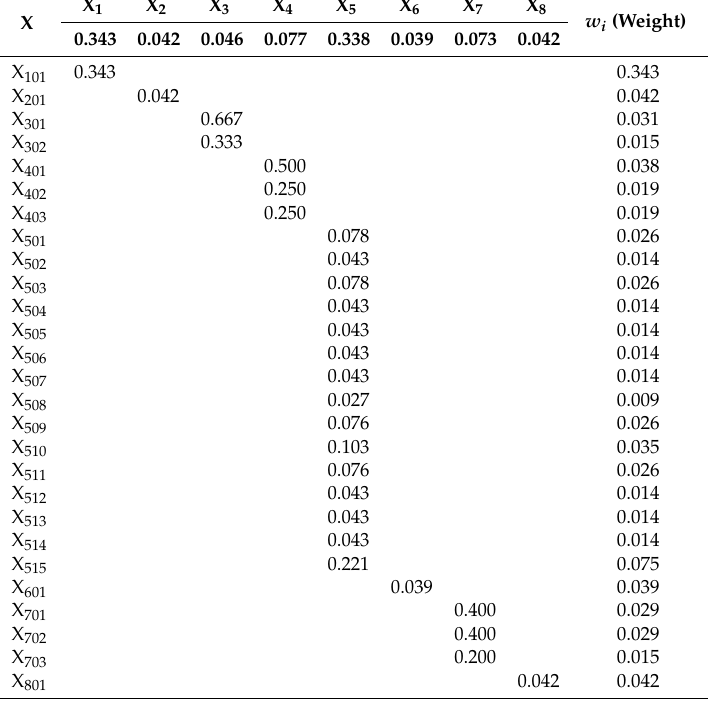
Table 3. Weight Summary Table.